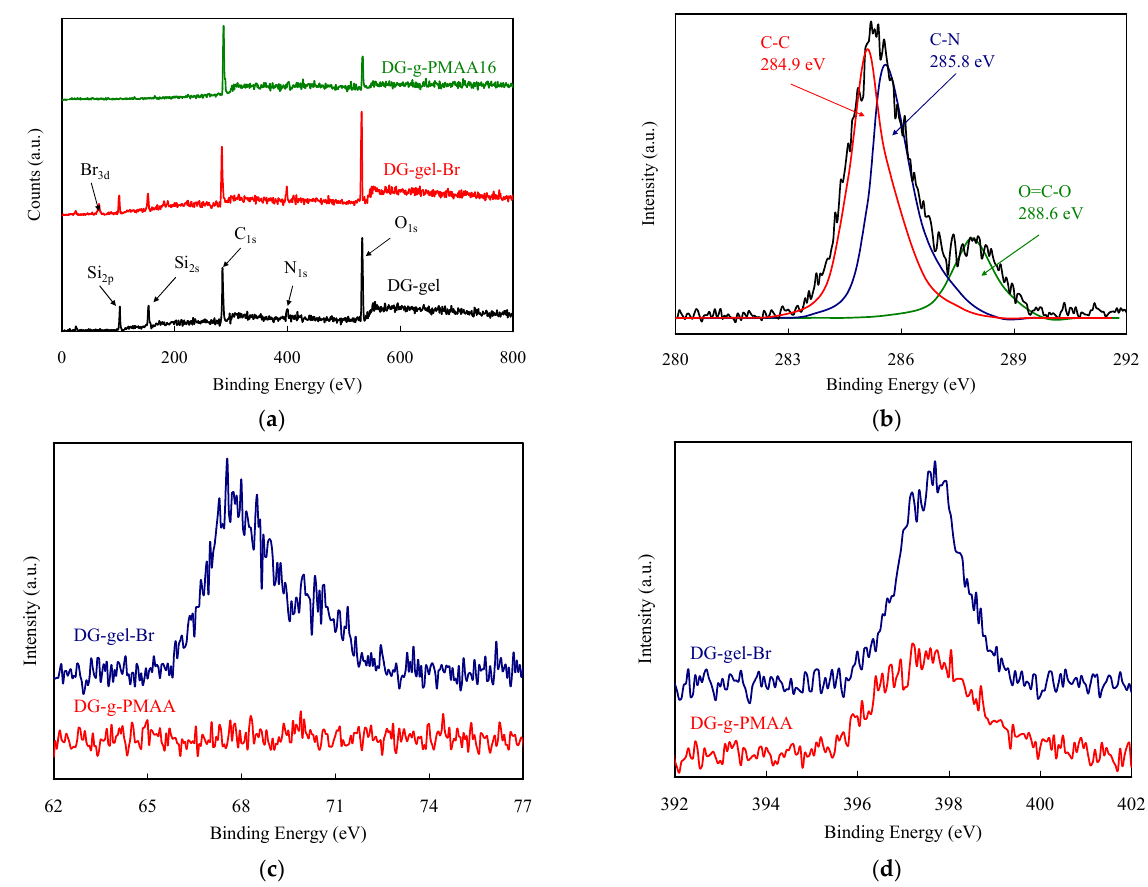
Figure 1. ( a ) XPS survey spectra of DG-gel, DG-gel-Br, and DG-g-PMAA16. ( b ) C 1s high-resolution spectrum of DG-g-PMAA16 with fitting of three distinct curves. ( c ) Br 3d and ( d ) N 1s high-resolution spectra of DG-gel-Br and DG-g-PMAA16.